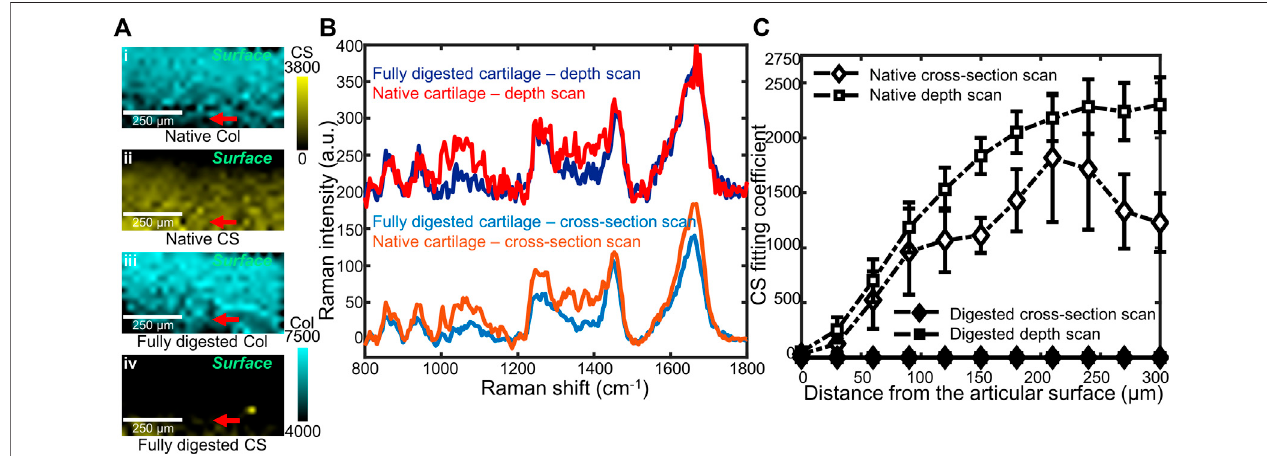
FIGURE 3 | (A) Representative coef fi cient maps of CS and collagen (Col) obtained by confocal Raman depth scans on native (i,ii), and fully digested (iii,iv) articular cartilage.Redarrows:the300 μ mdepthpositionatwhichspectrain (B) wereobtained. (B) RepresentativeRamanspectraofnativecartilageandfullydigestedcartilage, all taken from 300 μ m beneath the articular surface. Both cross-section scan and depth scan have been used, and a 200 a.u. offset was applied to each depth scan spectrum for clarity. (C) CS coef fi cient plotted as a function of distance from the articular surface, up to 300 µm beneath the surface. Data from two cross-section scans (native and digested) as well as two depth scans (native and digested) are plotted ( n (cid:2) 4).